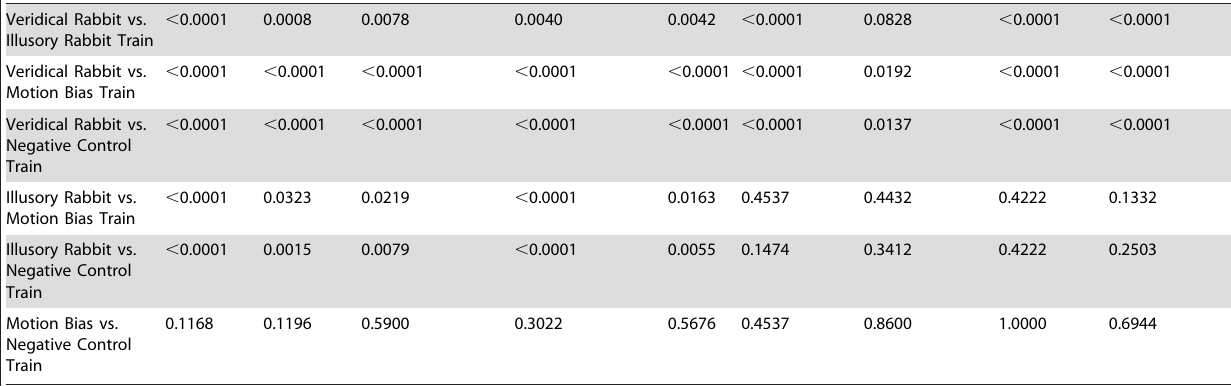
Adducted All-Flexed Middle-Extended Index-Abducted Vulcan Index-Flexed Middle-Flexed Ring-Flexed All-Abducted , 0.0001 Veridical Rabbit vs. Illusory Rabbit Train